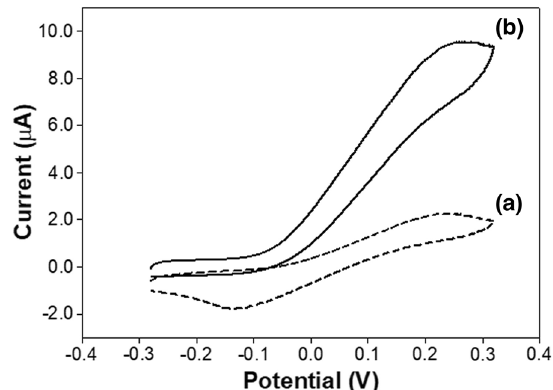
Fig. 4 Cyclic voltammetric curves of GOx/FCA/PEG/SWCNT electrode‑based biosensor at a scan rate of 0.05 V/s: a recorded in the absence of glucose in a 0.1 M PBS solution, b recorded after the addition of 10 mM